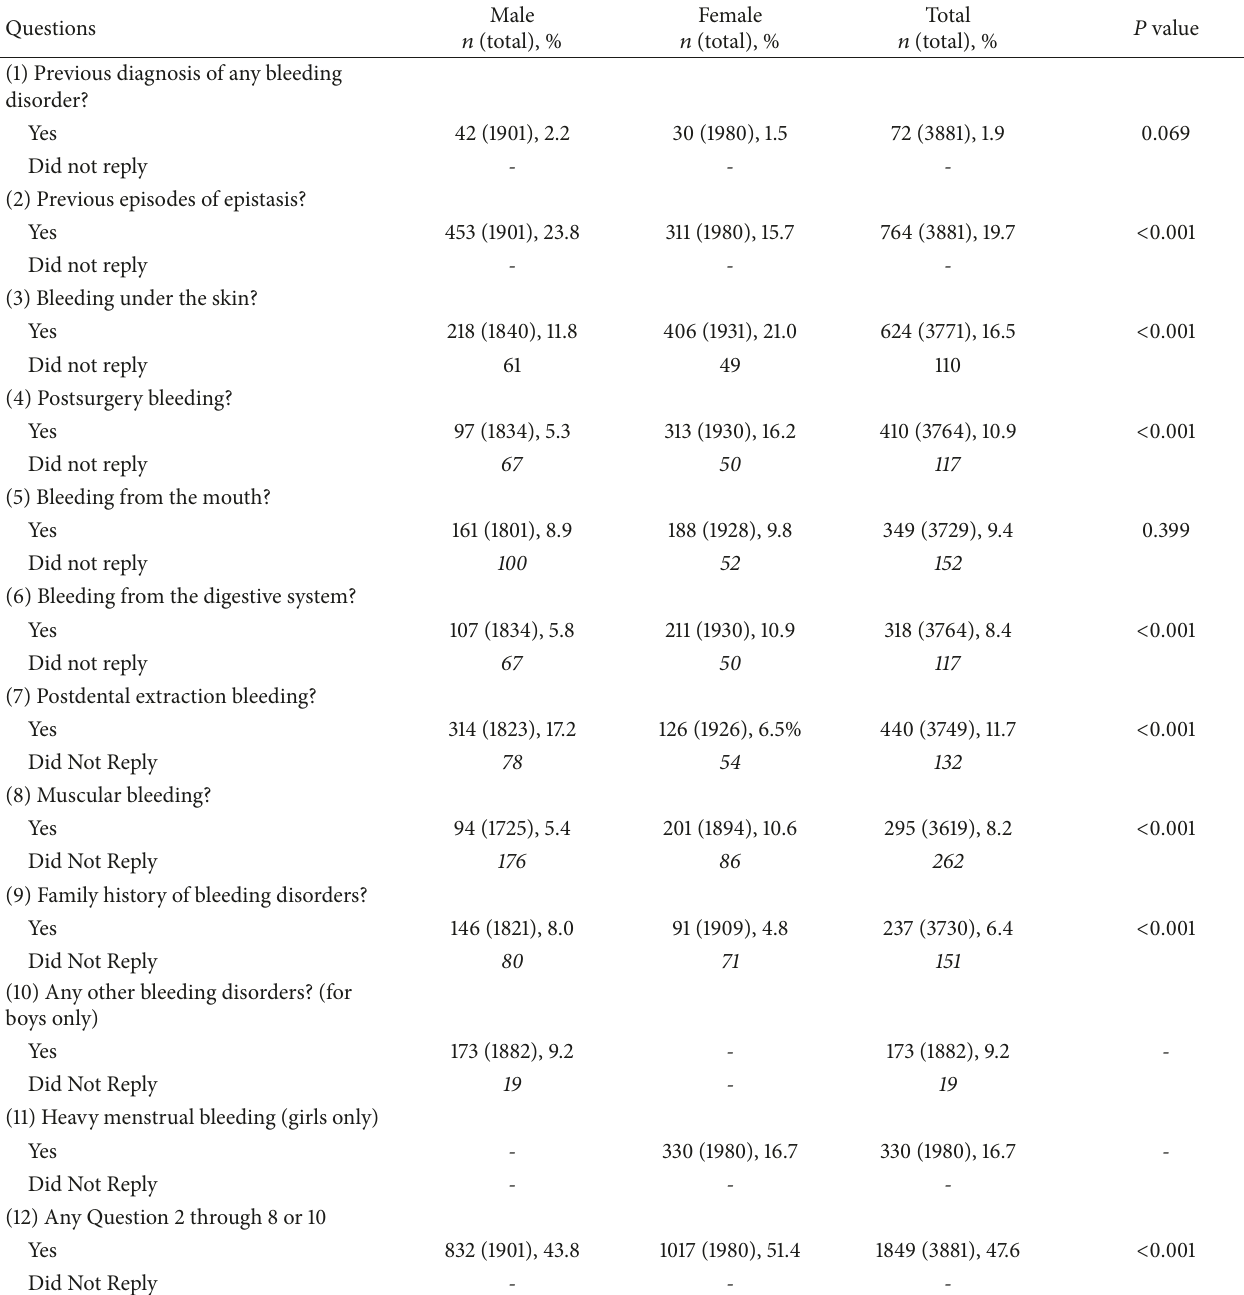
Table 2: Responses to Phase I of the Survey (𝑛 = 3881)